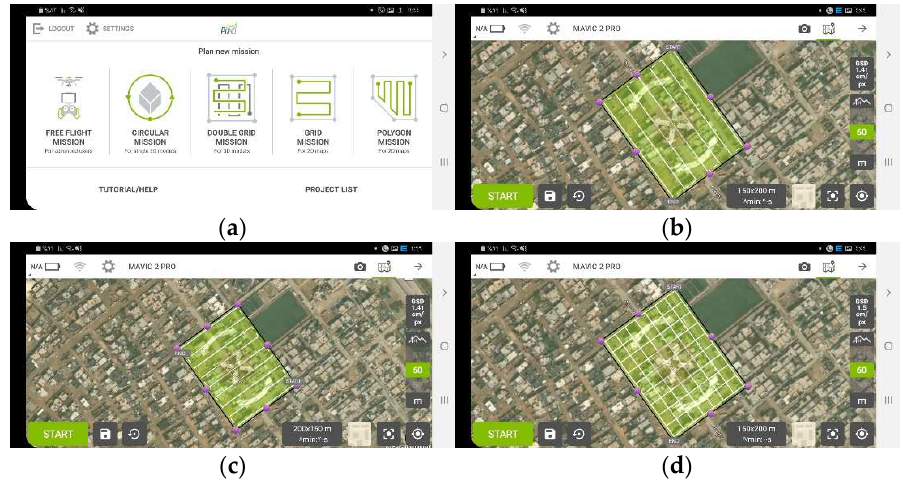
Figure 3. Pix4D capture software: ( a ) the main page, ( b ) first mission, ( c ) second mission, ( d ) third